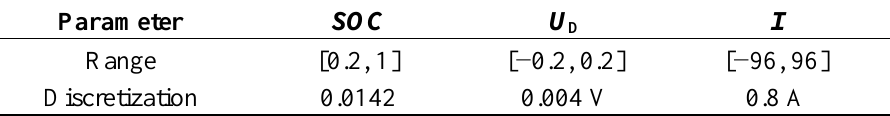
Table 2. The discretization for control and state